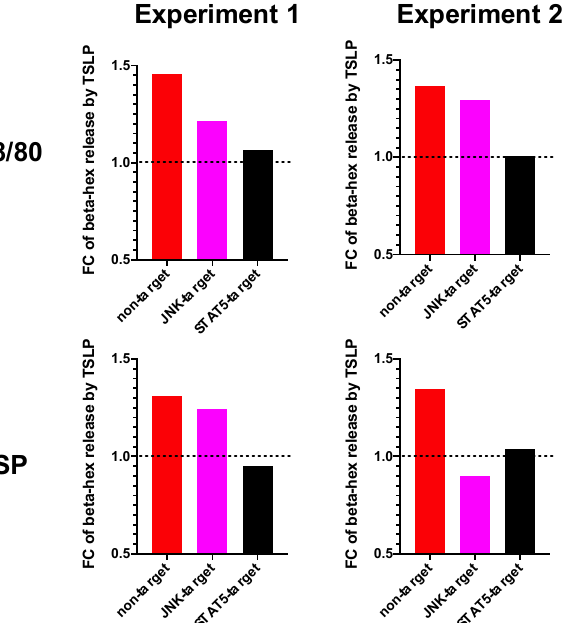
Figure 6. TSLP acts via STAT5 to increase MRGPRX2-mediated degranulation—verification by RNAi-mediated knockdown. MCs were subjected to RNA interference as described in Methods for 2 d, after which time cells were pre-treated or not with TSLP (7.5 ng/mL) prior to being stimulated by c48/80 (10 µg/mL) or SP (30 µM). Beta-hex(osaminidase) release was assessed after 30 min, spontaneous release was assessed analogously, and the net release calculated. Results from two separate experiments (MC cultures) are depicted as ratios “with TSLP/without TSLP” for the different siRNAs (calculated as in Figure 5C,D). The net beta-hex release of these experiments (analogous to Figure 5A,B) can be found as Figure S6.